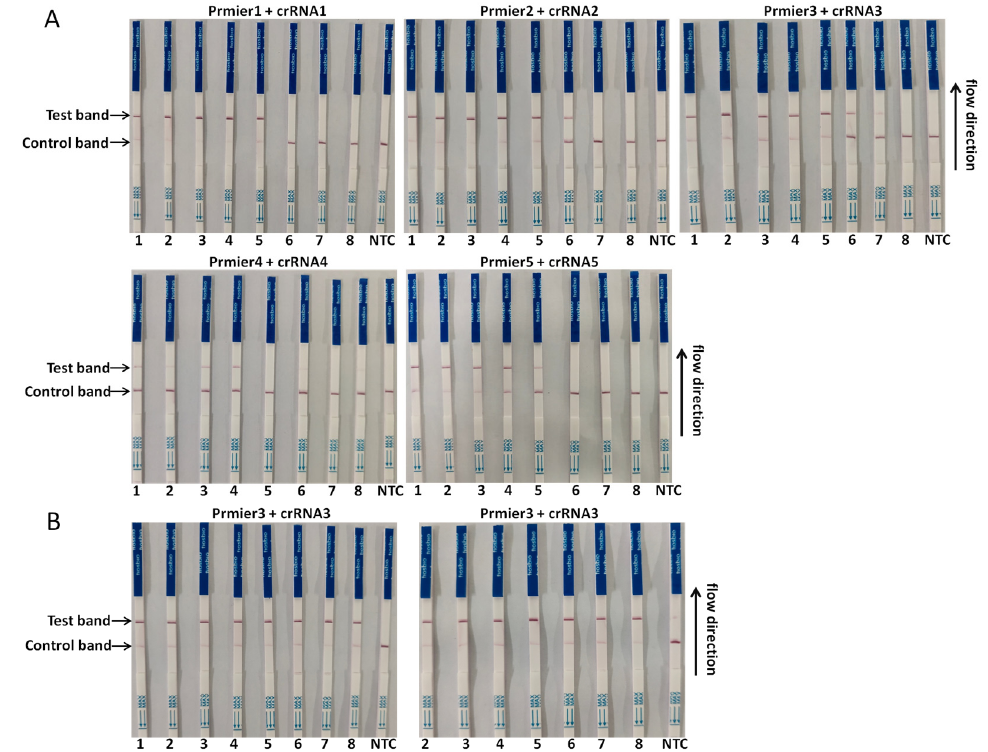
Figure 3. Sensitivity test of the CRISPR/Cas13a-LFD. A ten-fold serial dilution of pUC57-p72 was used as the detection template. ( A ) Sensitivity test of different primer and probe combinations; ( B ) sensitivity of the primer3 + crRNA3 combination after reaction system optimization. Detection re-